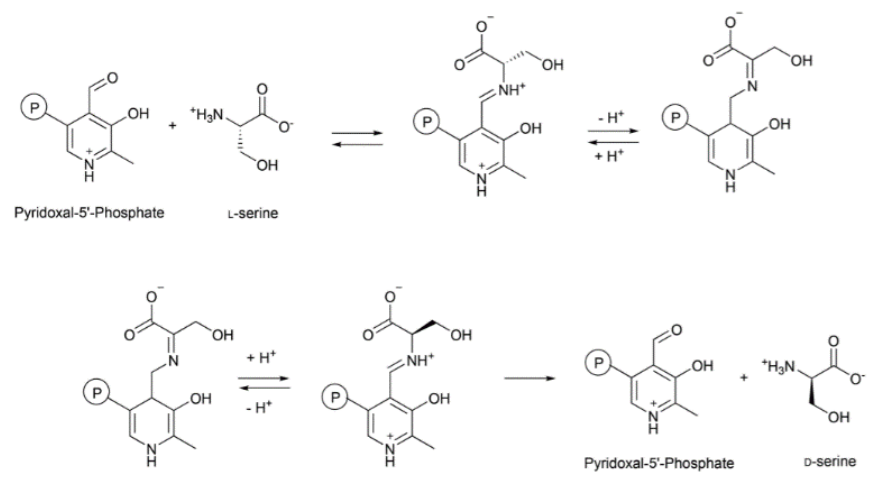
Scheme 1. Mechanism of action of pyridoxal-5 ′ -phosphate-dependent serine racemase. Repro- duced from [13] upon adaption from [12].